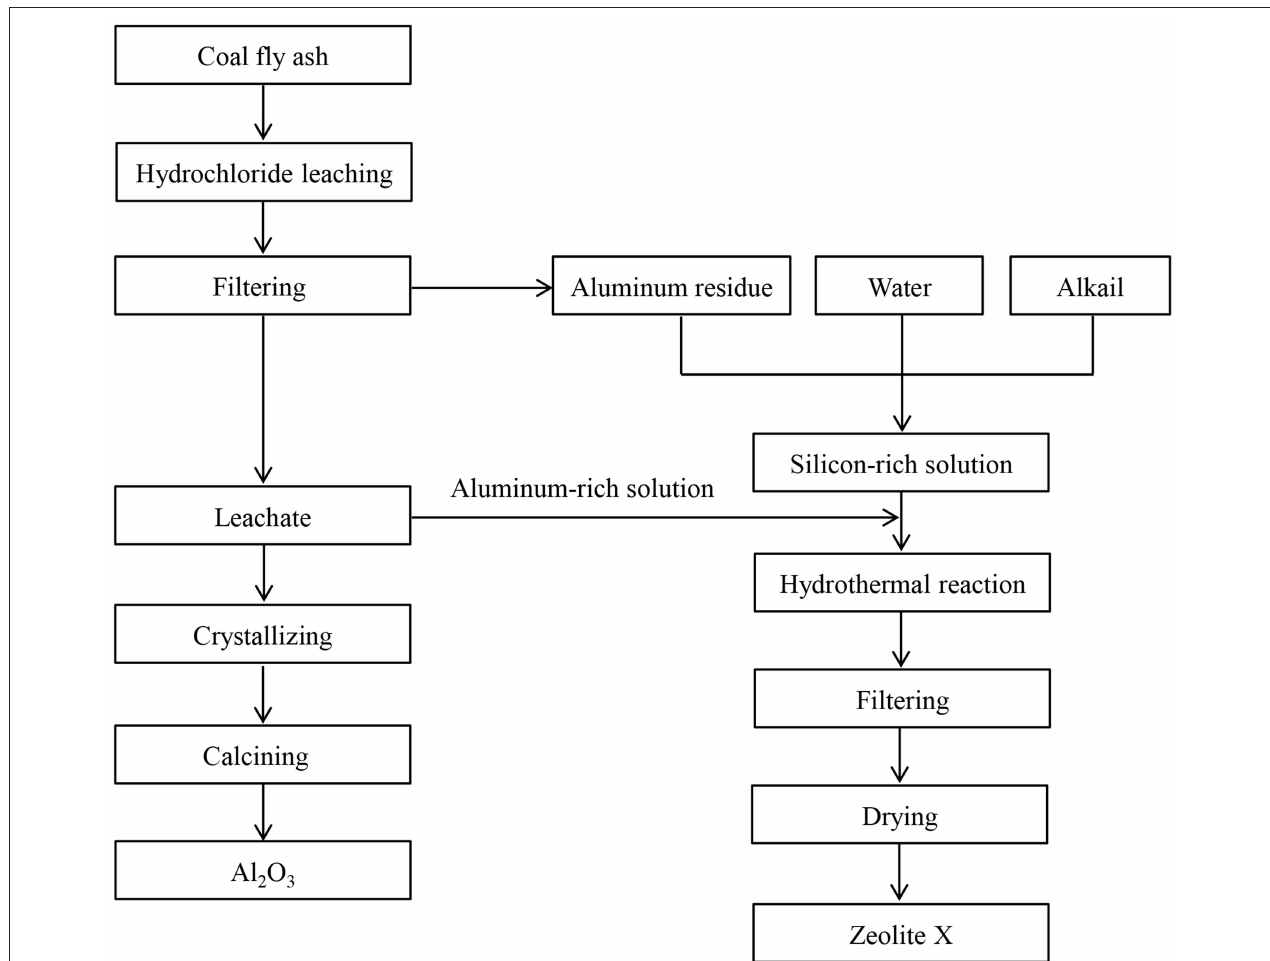
FIGURE 1 | Process diagram for synthesizing zeolite X by aluminum